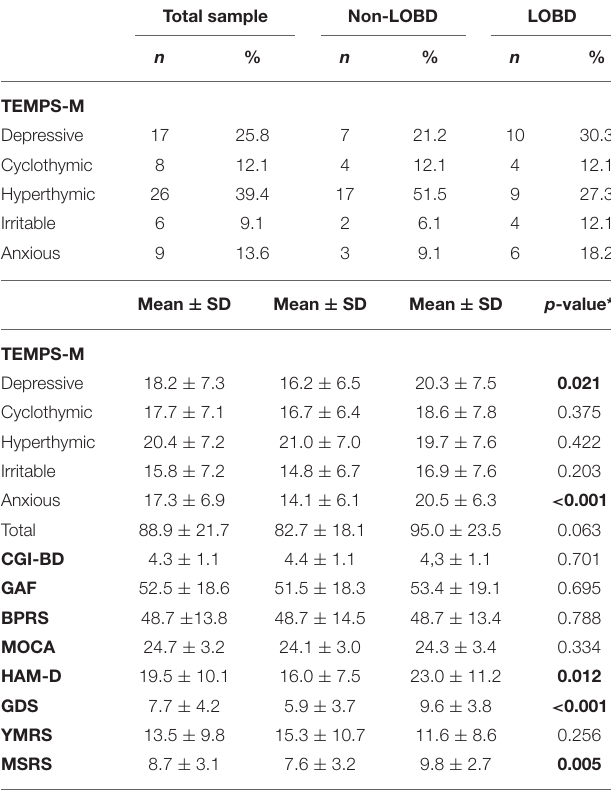
TABLE 2 | Psychopathological